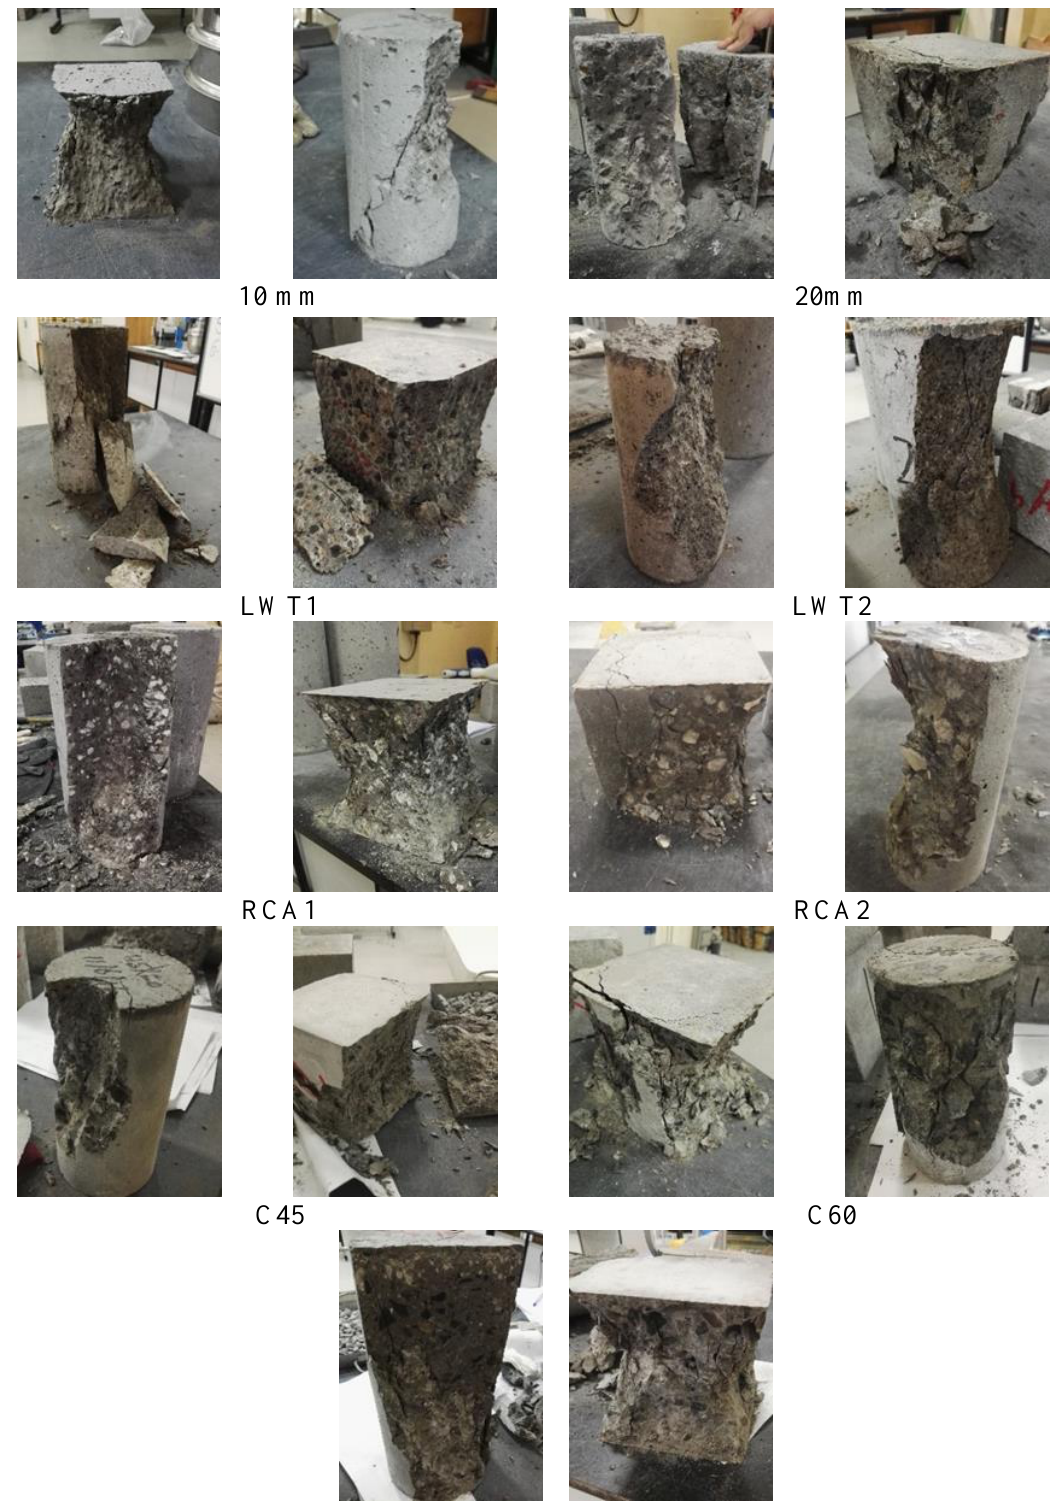
Figure 5. Failure modes of cube and cylinder specimens from all mixes.